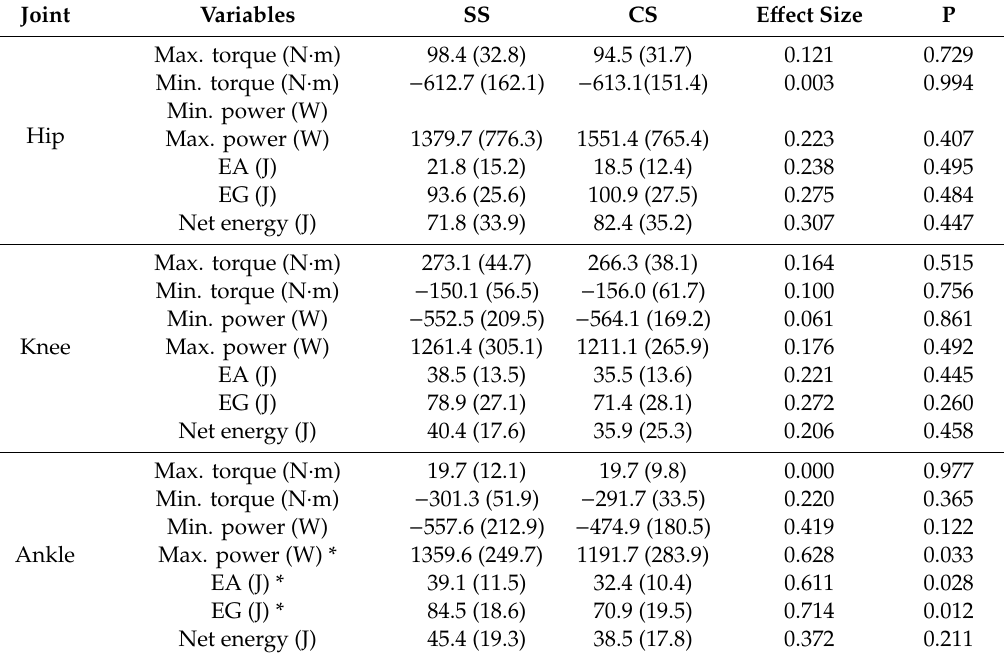
Table 4. Hip, knee and, ankle joint kinetics during LJs (n = 30, Mean (SD)).